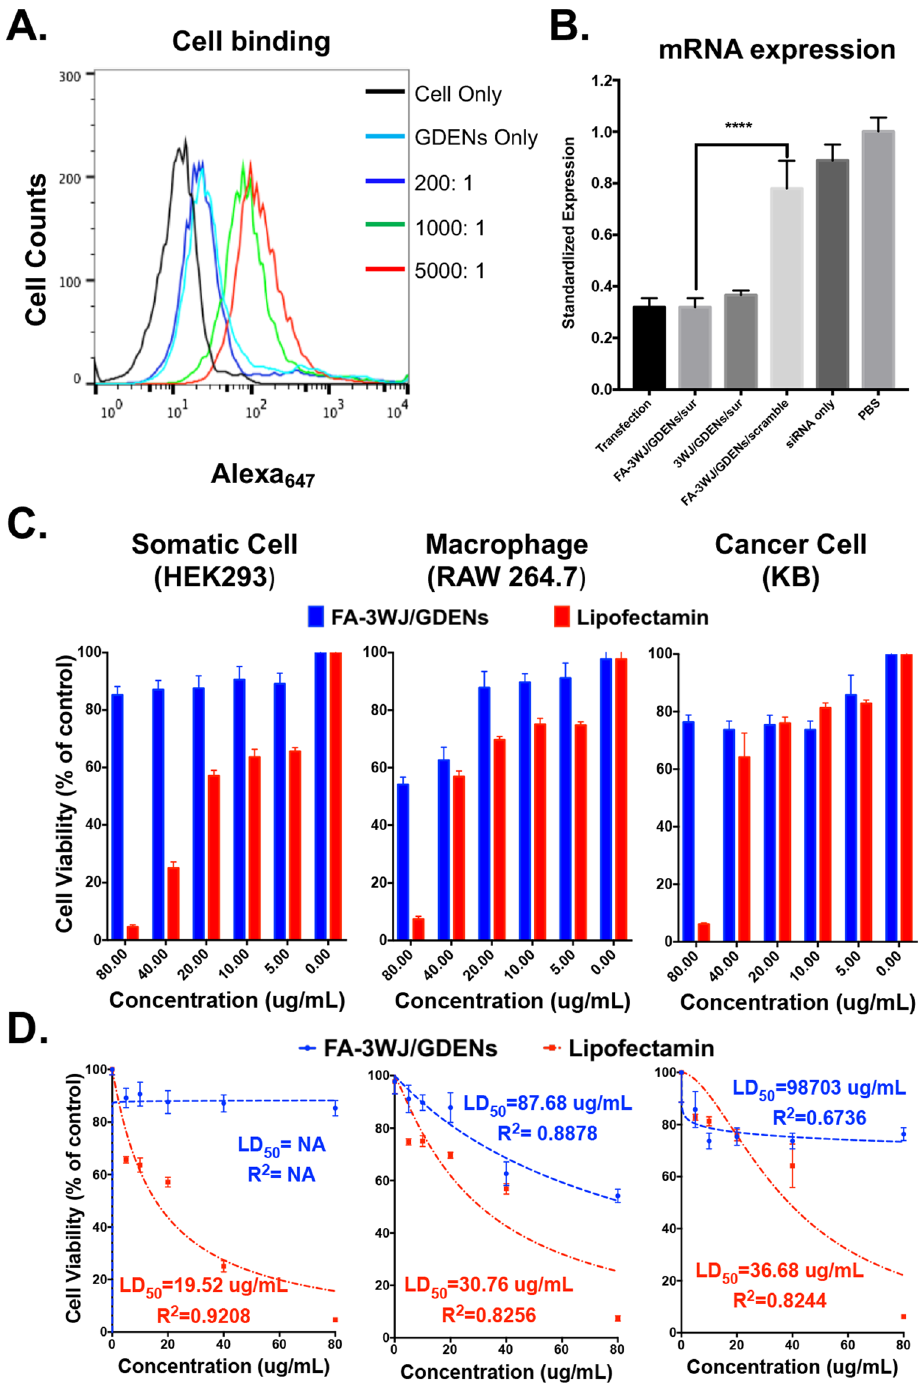
Figure 7. Cancer cell targeting and delivery of siRNA by ligand-displaying GDENs. ( A ) Cancer cell targeting capacity was evaluated by flowcytometry showed dose-dependent of FA-arrowtail RNA ratio verse equal amount of GDENs. ( B ) qRT-PCR evaluating in vitro delivery of survivin siRNA to KB cells by FA-arrowtail RNA ligand displayed GDENs. mRNA levels were standardized by PBS group as 1 and shown as mean ± S.D. fold changes of individual groups. Results are presented at n = 3 for each group for one-way ANOVA multiple comparisons, Tukey’s adjusted p of FA-3WJ/GDENs/sur compare to transfection, 3WJ/GDENs/sur and FA- 3WJ/GDENs/scramble are > 0.9999, 0.9174 and < 0.0001( **** ). ( C ) Cytotoxicity of FA-3WJ/GDENs evaluated by MTT assay expressed as histogram and fit with nonlinear regression curve ( D ). Samples were incubated with cells in quadruplicate for 24 hours before adding MTT dye. Cell viability were standardized by the control group of “Cell Only” as 100%. Equivalent lipofectamin 2000 were used for comparison. N = 4, error bar indicates ±